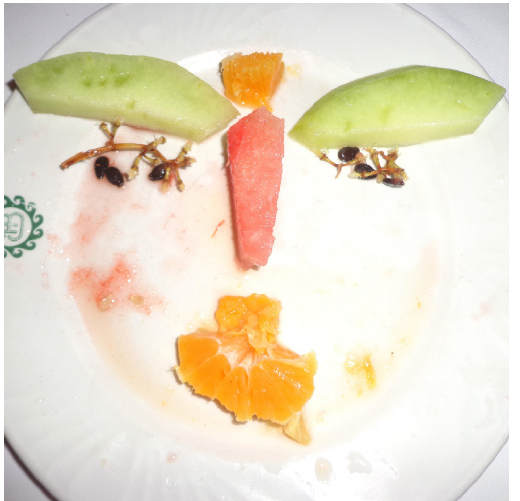
Fig 2. An example of Face-n-Food images. One of the most resembling a face, eliciting most female-face responses, and at the same time, one of the most likable Face-n-Food